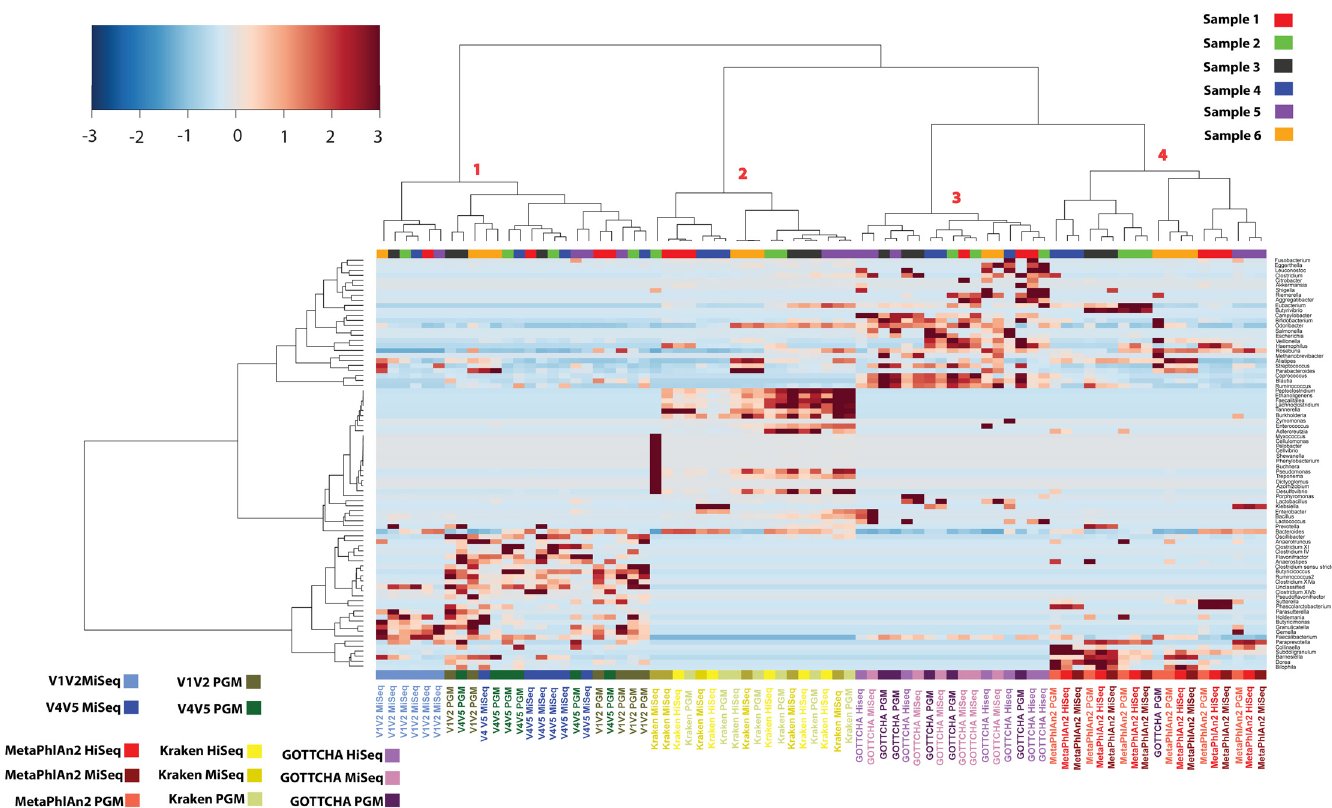
Fig 1. Heat-plot representing the taxonomic composition of the samples at genus level. The heat-plot also includes amplicon data long shotgun datasets from three classifiers namely: MetaPhlAn2, Kraken and GOTTCHA. Only genera in a minimum of 20% of datasets were retained. The method of correlation used was Spearman along with Ward D2 Clustering (PGM = Ion Personal Genome